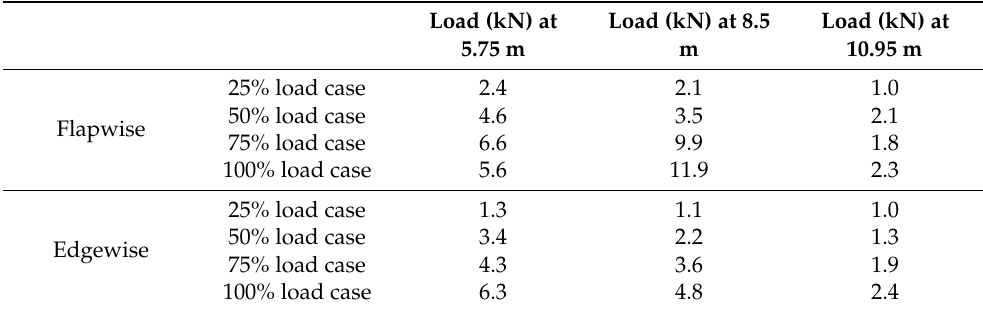
Table 2. Loads (in kN) applied to the blade at 3 locations during the static testing in both the flapwise and edgewise